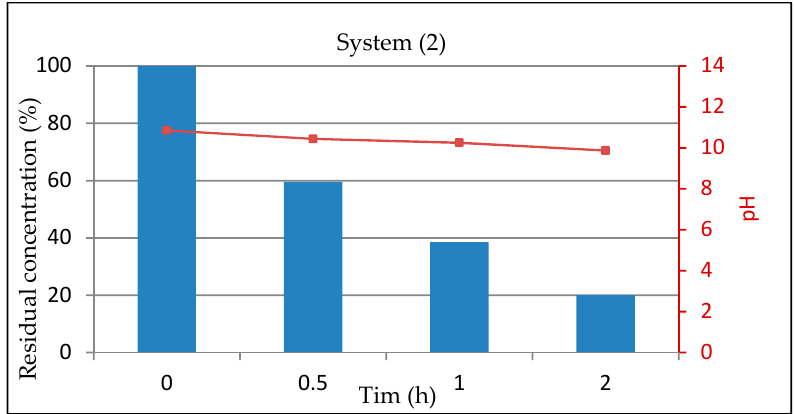
Figure 6. Residual concentration (%) and pH for System 2, as a function of the UV irradiation time exposure.